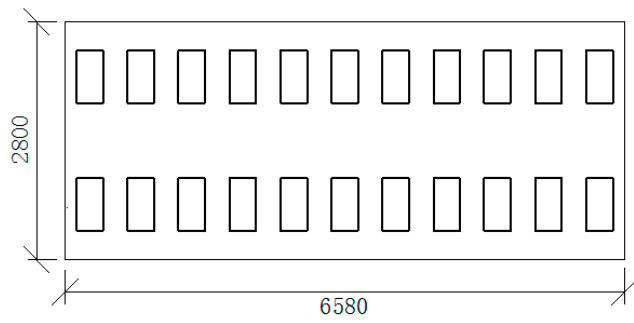
Figure 31. Original size of track bed.